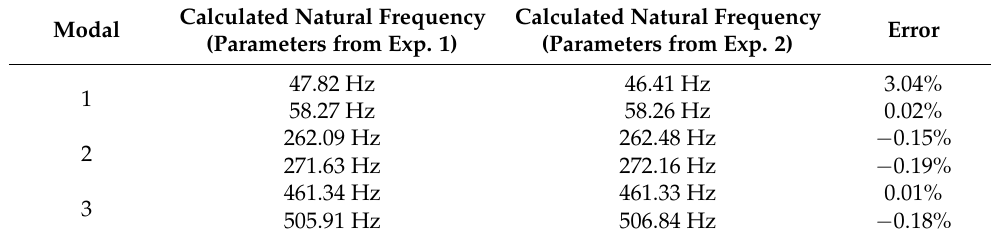
Table 6. Percentage deviations of the calculated natural